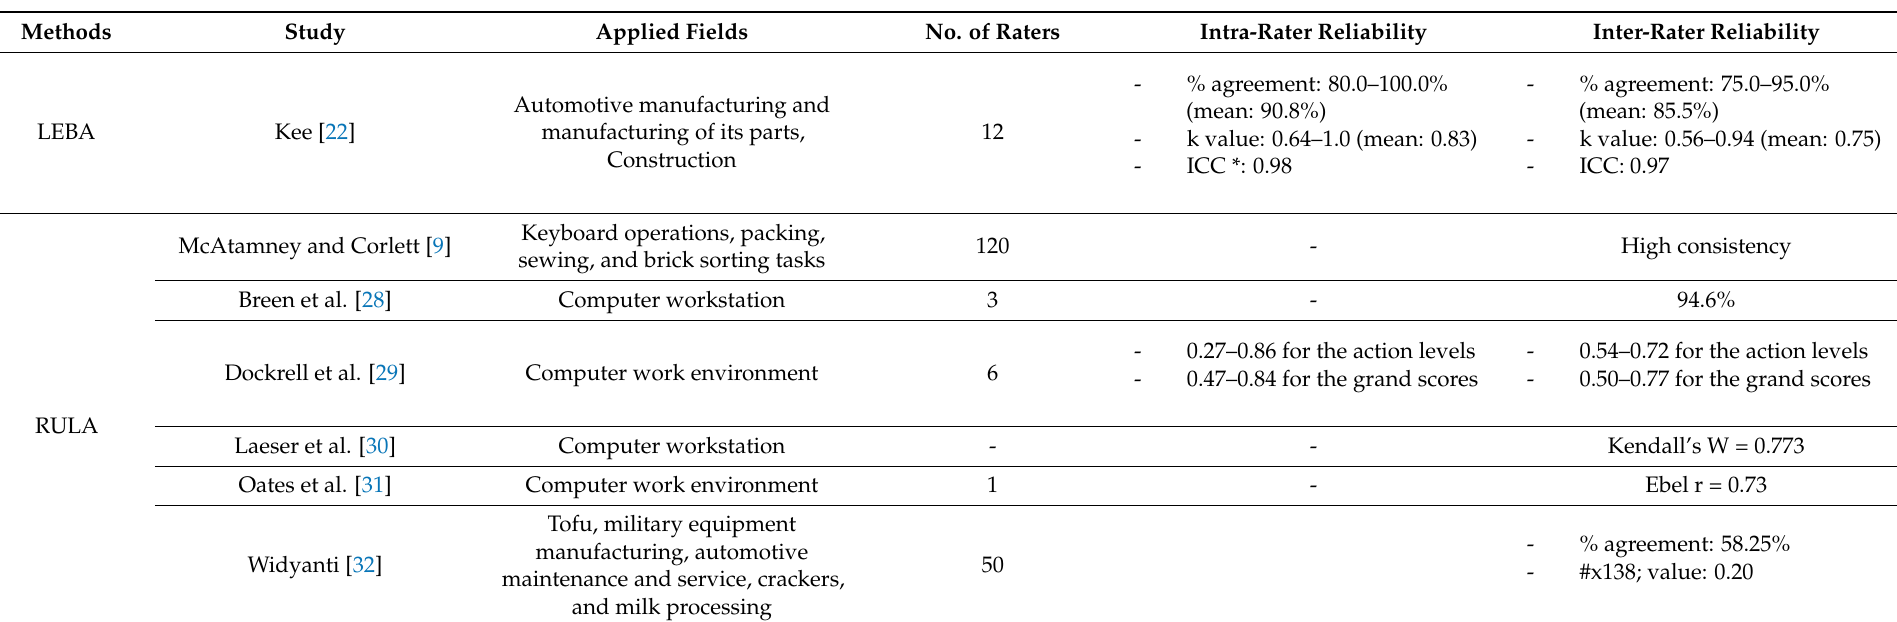
Table 6. Intra- and inter-rater reliabilities by